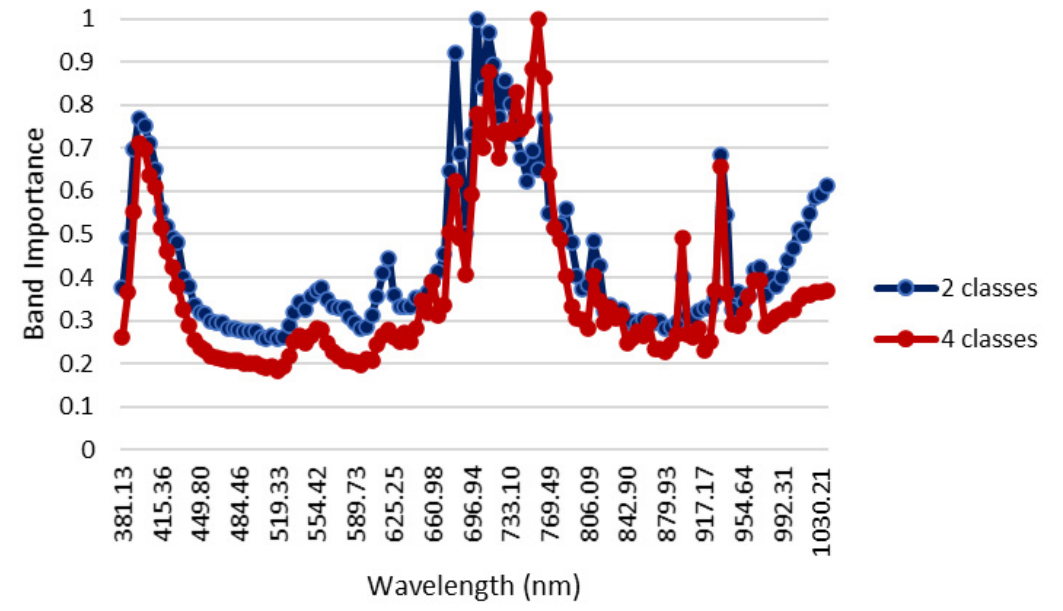
Figure 12. Band importance determined by RF on the tubers differentiation phenological stage.